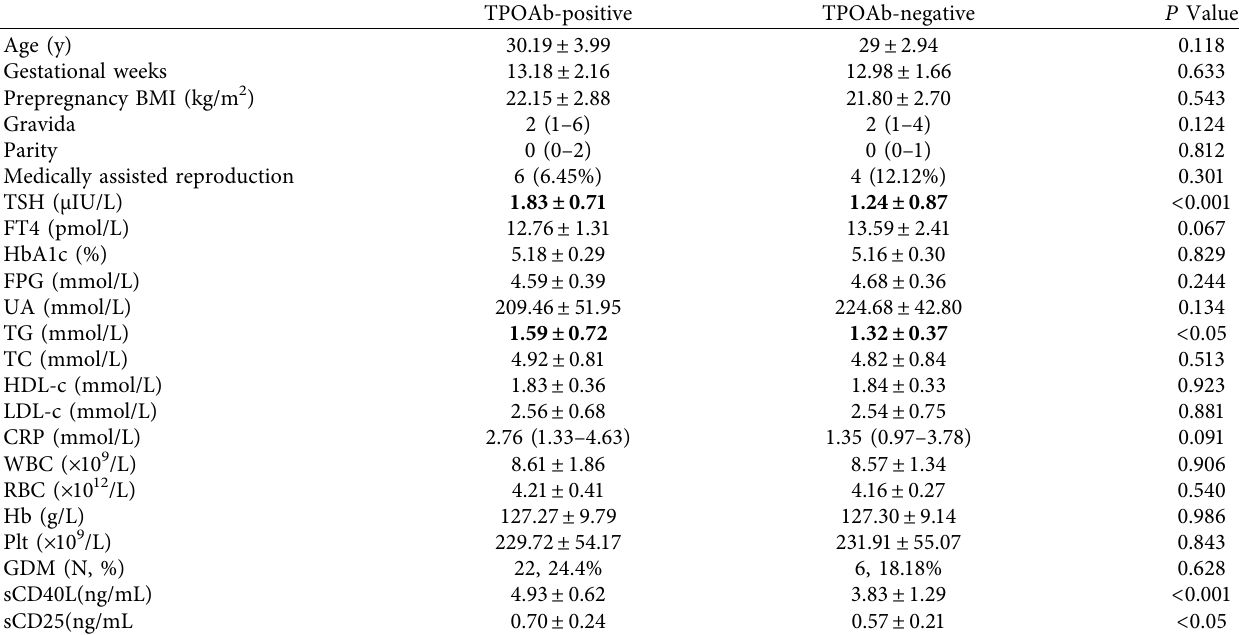
Table 1: Baseline and demographical characteristics and laboratory parameters of TPOAb-positive pregnancies and TPOAb-negative controls.